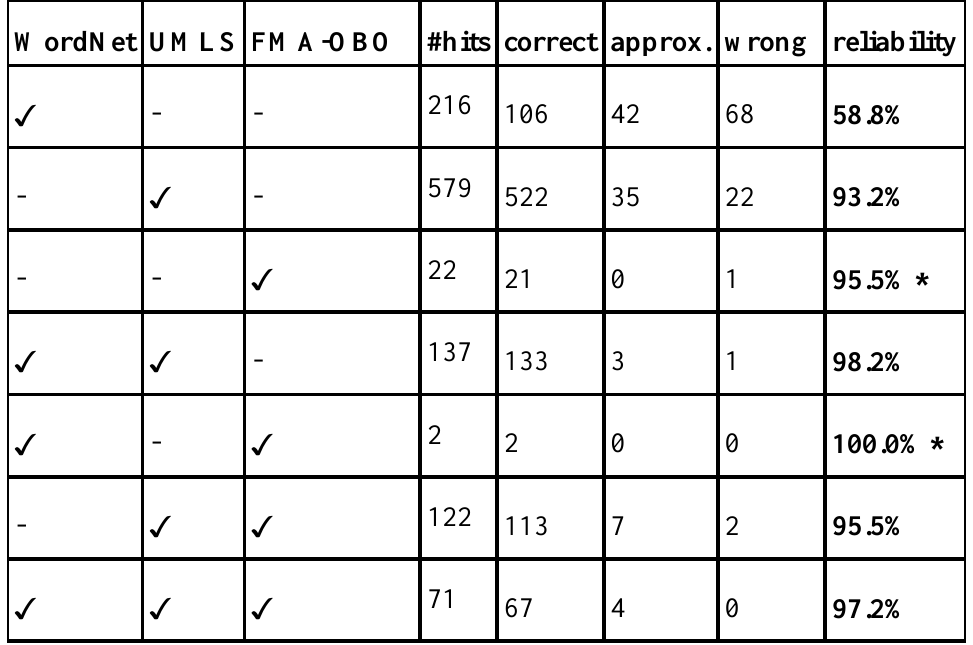
Table 5: Reliability by source. * denotes reliability scores in categories < 30